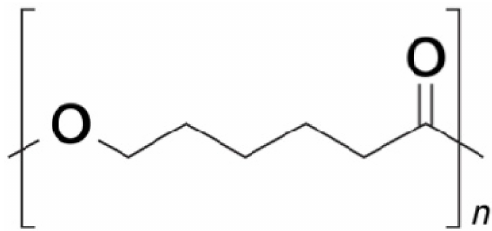
Figure 8. Chemical structure of